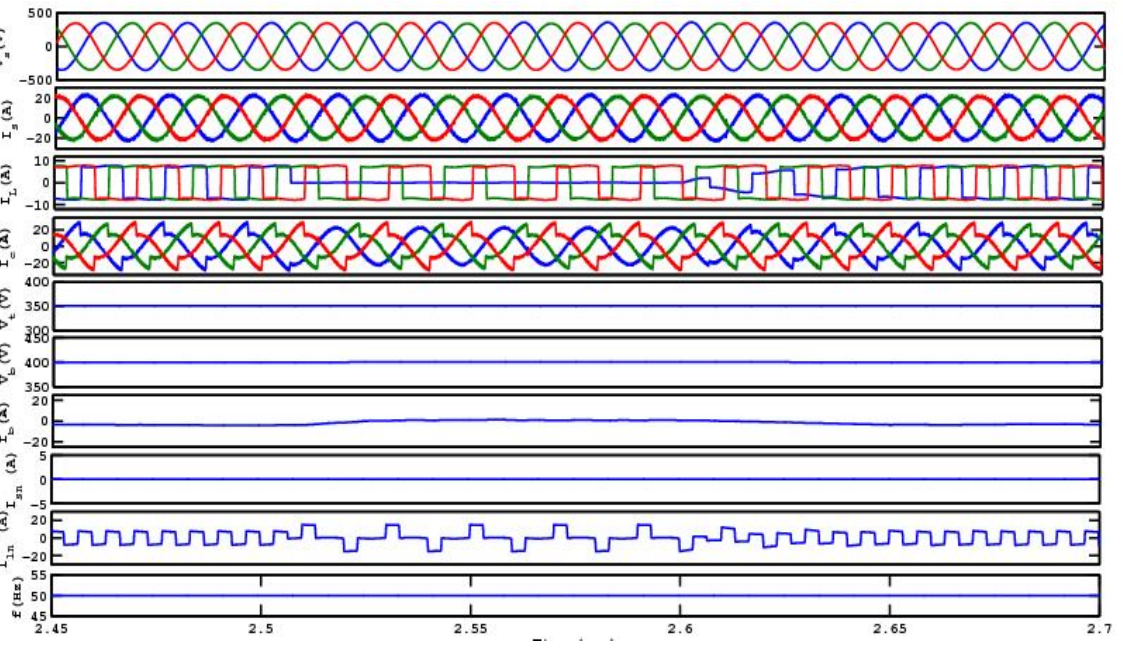
Figure 9. Performance of the Wind power unit with nonlinear load at constant wind speed. Figure 10 shows voltage and current at the source side for a linear load, when the wind speed changes. Wind speed changes from 10 m/s to 13 m/s at 3.5 s. After a moment of instability, the system comes back to its normal operation. Frequency and the PCC voltage come to their standard value. When the wind speed increases, the reactive power absorbed by the system increases, which causes the terminal voltage to drop. The fre- quency increases. The controller acts quickly to mitigate these variations. All the varia- tions are suppressed and the stability is maintained by the controller. The terminal volt- age and the frequency are brought back to their standard values very quickly by the controller. The battery current increases as the battery will try to absorb the extra power generated. The source neutral current remains zero, as the load neutral current completes its path through the transformer neutral.